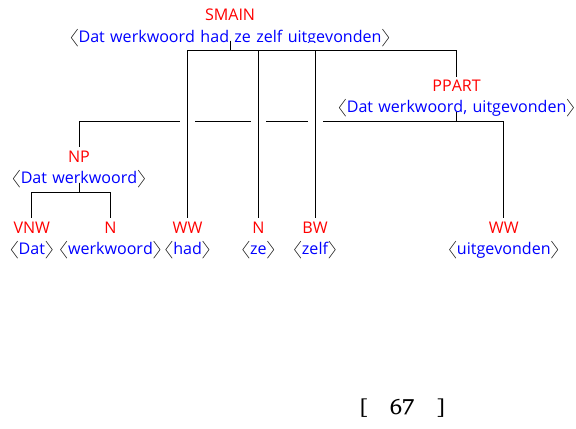
Figure 5: A discontinuous tree with yield